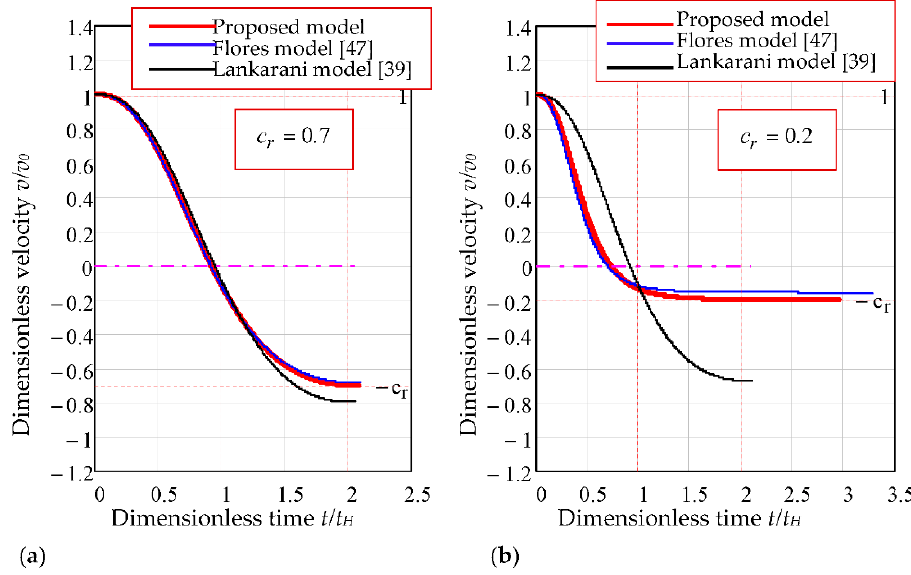
Figure 18. Velocity variation with time for the three models: ( a ) 𝑐 (cid:3045) = 0.7 and ( b ) 𝑐 (cid:3045) = 0.2 .